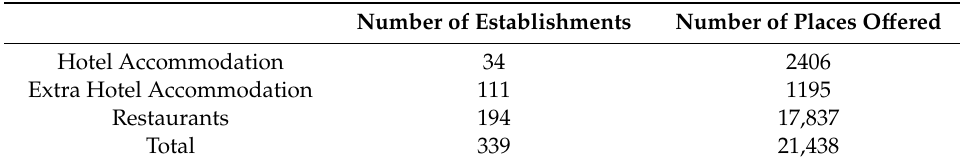
Table 1. Number of tourist services in the city of Cáceres according to type (Observatorio Turístico de Extremadura 2019).